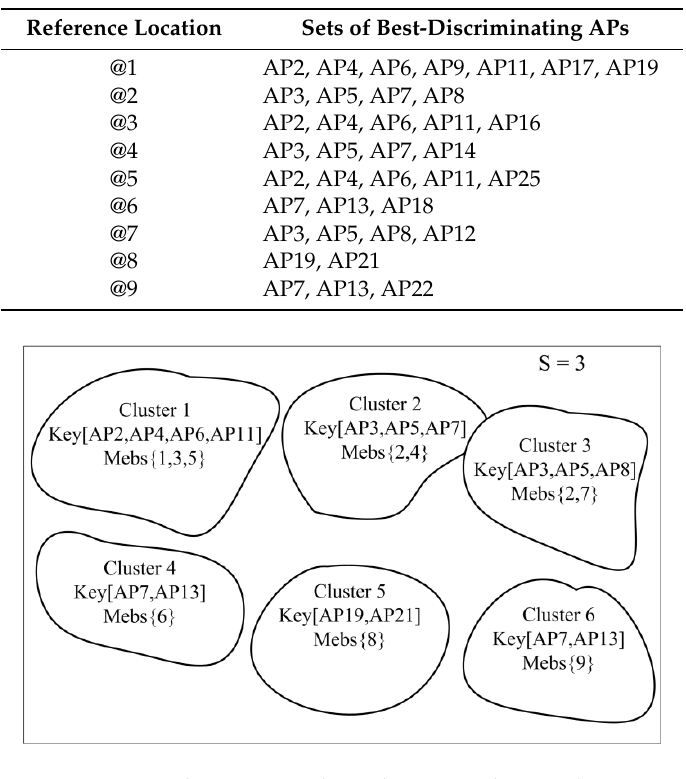
Table 5. Sets of best-discriminating APs of reference locations.